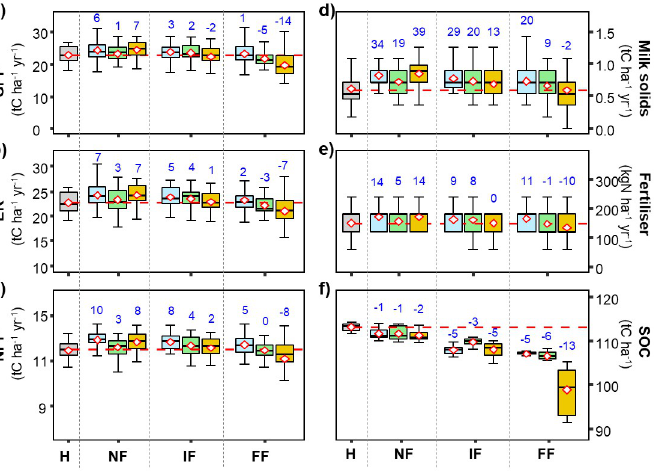
Fig 5. Box and whiskers charts for modelled responses of grazed grassland under constant atmospheric CO 2 concentration (380 ppm). Other information as for Fig 4.